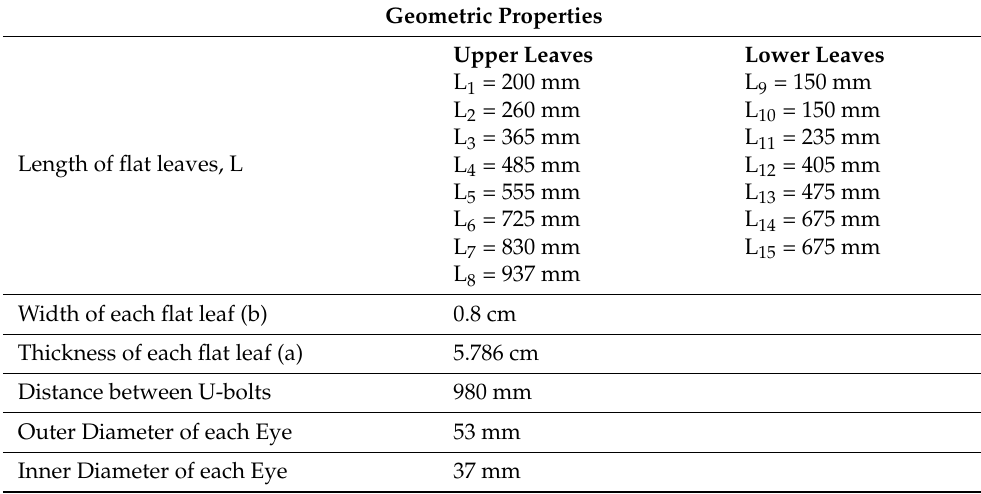
Table 1. Geometric properties of the leaf spring system designed.